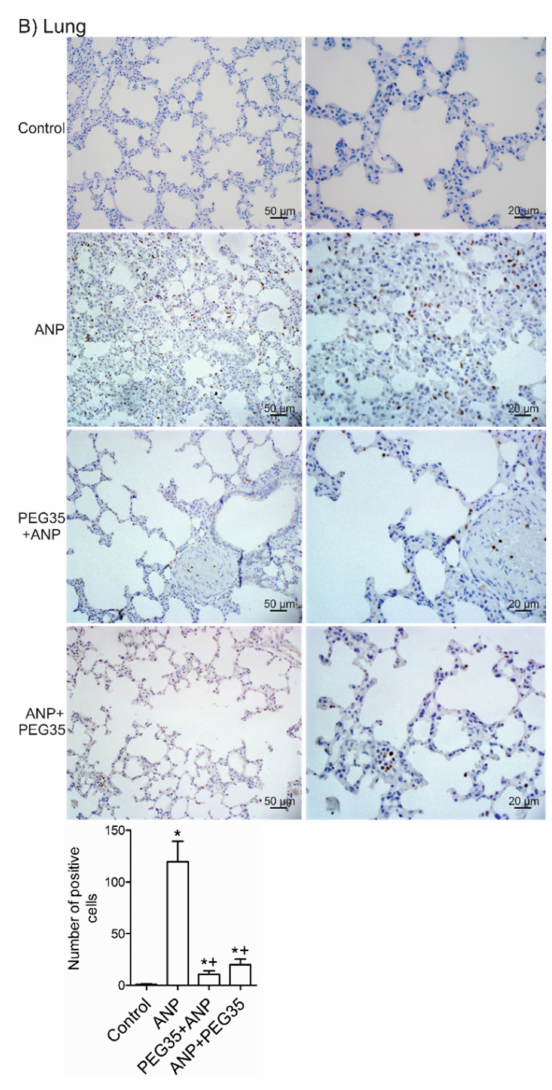
Figure 5. E ff ects of PEG35 treatment on acute necrotizing pancreatitis-induced myeloperoxidase expression. ( A ) Top, Representative images of pancreatic sections stained with anti-MPO antibody (brown). Bottom, Pancreas MPO immunostaining quantification represented as the average number of positive cells per field. ( B ) Top, Representative images of lung sections stained with anti-MPO antibody (brown). Bottom, Pulmonary MPO immunostaining quantification represented as the average number of positive cells per field. ANP, Acute Necrotizing Pancreatitis. PEG35, Polyethylene glycol 35. Scale bar, 50 and 20 µ M. * p < 0.05 versus Control, + p < 0.05 versus